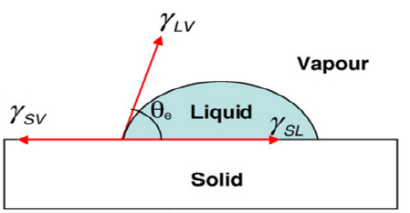
Figure 11. Schematic diagram of contact angle measurement.